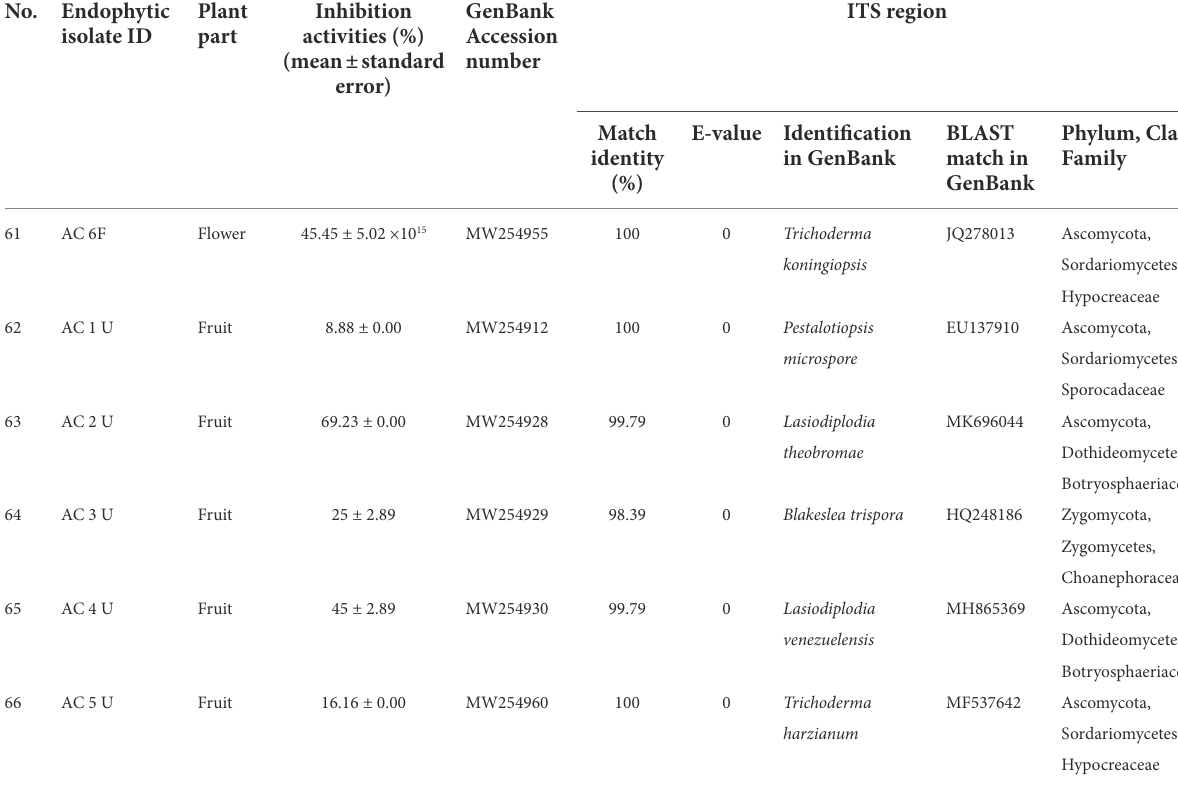
4P) petiole, and Trichoderma sp. (AC 9R) root were observed to exhibit stronger inhibition where the mycelia of the antagonists had breached into C. fimbriata colony (Figure 2). Of these, four fungal isolates namely T. koningiopsis (AC 1S) stem, Lasiodiplodia sp. (AC 2 U) fruit, N. sphaerica (AC 4P) petiole, and Trichoderma sp. (AC 9R) root colonised almost 99% of the culture plate. Although N. sphaerica (AC 7 l) leaf and N. sphaerica (AC 3F) flower did not colonise the entire culture plate, there was no growth of C. fimbriata observed. the pathogen C. fimbriata in dual culture assay are shown in Figure 3. Lasiodiplodia sp. (AC 2 U) isolated from fruit recorded the highest I% (69.23%), followed by Trichoderma sp. (AC 9R) isolated from root, Nigrospora sphaerica ( AC 4P) isolated from petiole, Nigrospora sphaerica (AC 3F) isolated from flower, Trichoderma koningiopsis (AC 1S) isolated from stem, and Nigrospora oryzae (AC 7L) isolated from leaf with value 58.33%, respectively. Thirteen endophytic fungi from various plant parts of A. mangium showed no inhibition against C. fimbriata (Figure 4) namely A. aculeatinus (AC 3R) isolated from root, A. aculeatus (AC 19L) isolated from leaf, A. niger (AC 10S) isolated from stem, N. oryzae (AC 14L) isolated from leaf, Nigrospora sp. (AC 13S) isolated from stem, N. sphaerica (AC 9L) isolated from leaf, N. sphaerica (AC 2P) isolated from petiole, P. neglecta (AC 12L) isolated from leaf, Pestalotiopsis sp. (AC 4S) isolated from